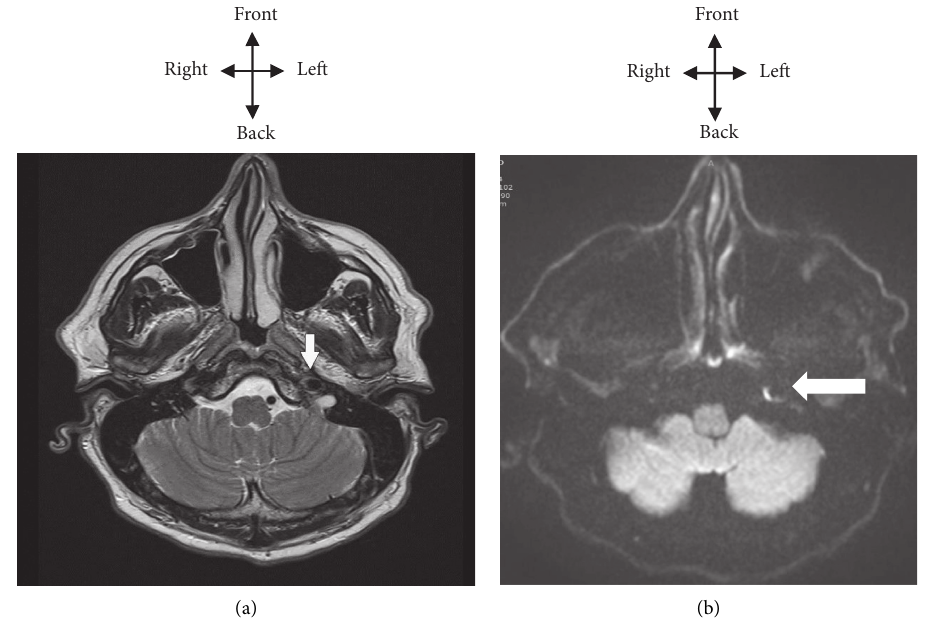
Figure 2: MRI of the neck vessels, T2 TSE axial (a) and diffusion axial (b), aneurysm ectasia of the left internal carotid with parietal irregularity.